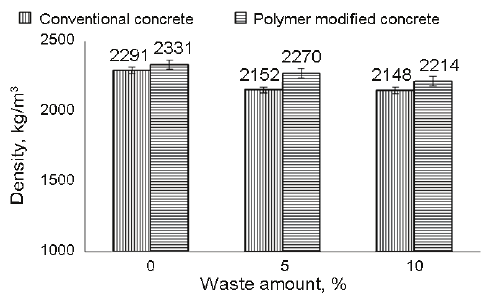
Fig. 3. the influence of ecW amount on concrete sample